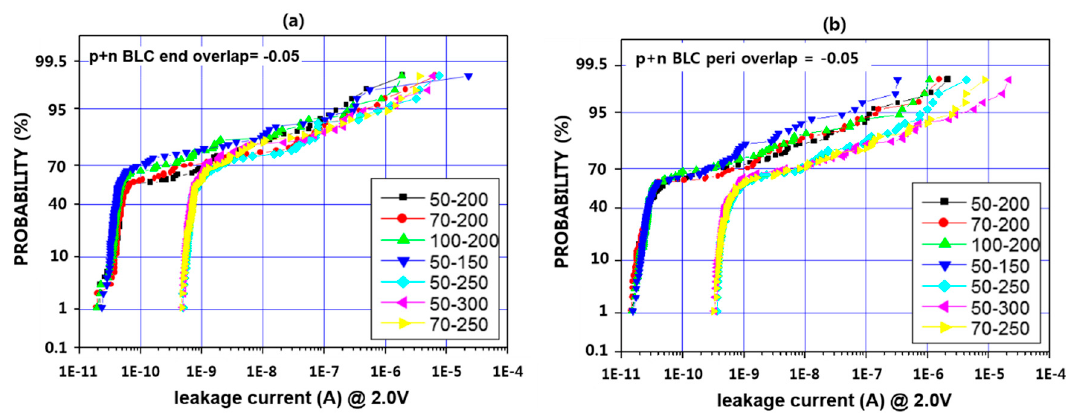
Figure 7. Contact P + N BLC leakage at overlap − 0.05 according to RF etch amount and IMP Ti deposition thickness. ( a ) end type ( b ) peri type (unit: Å).